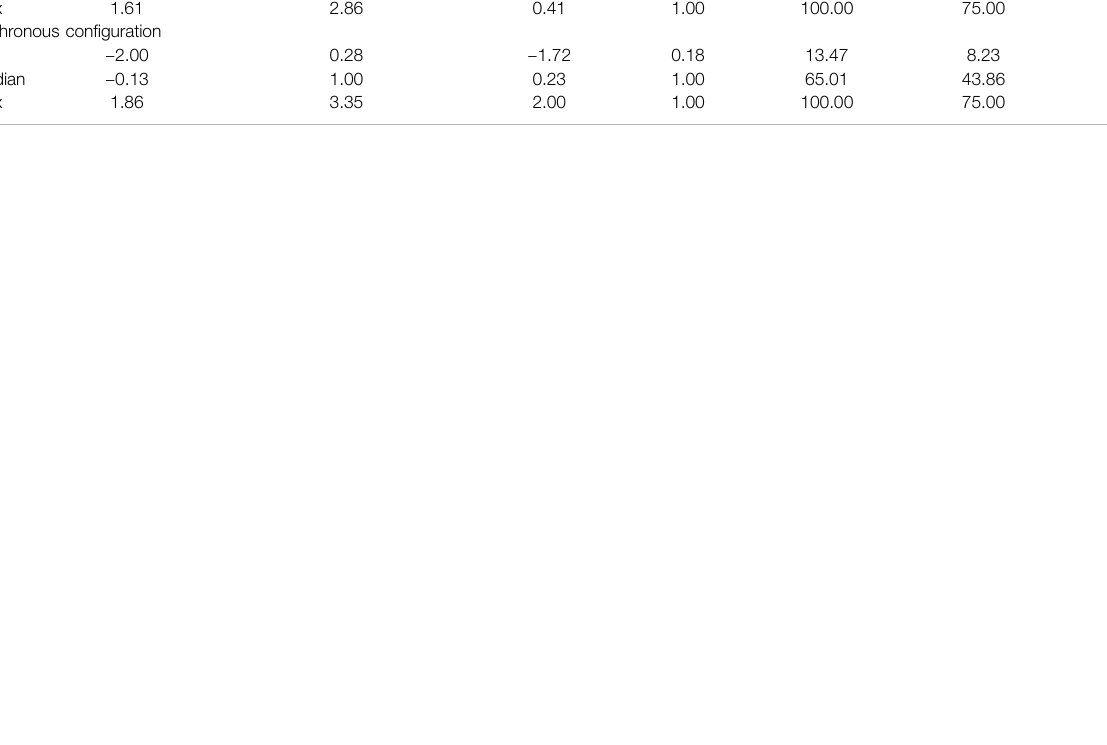
Conventional con fi guration